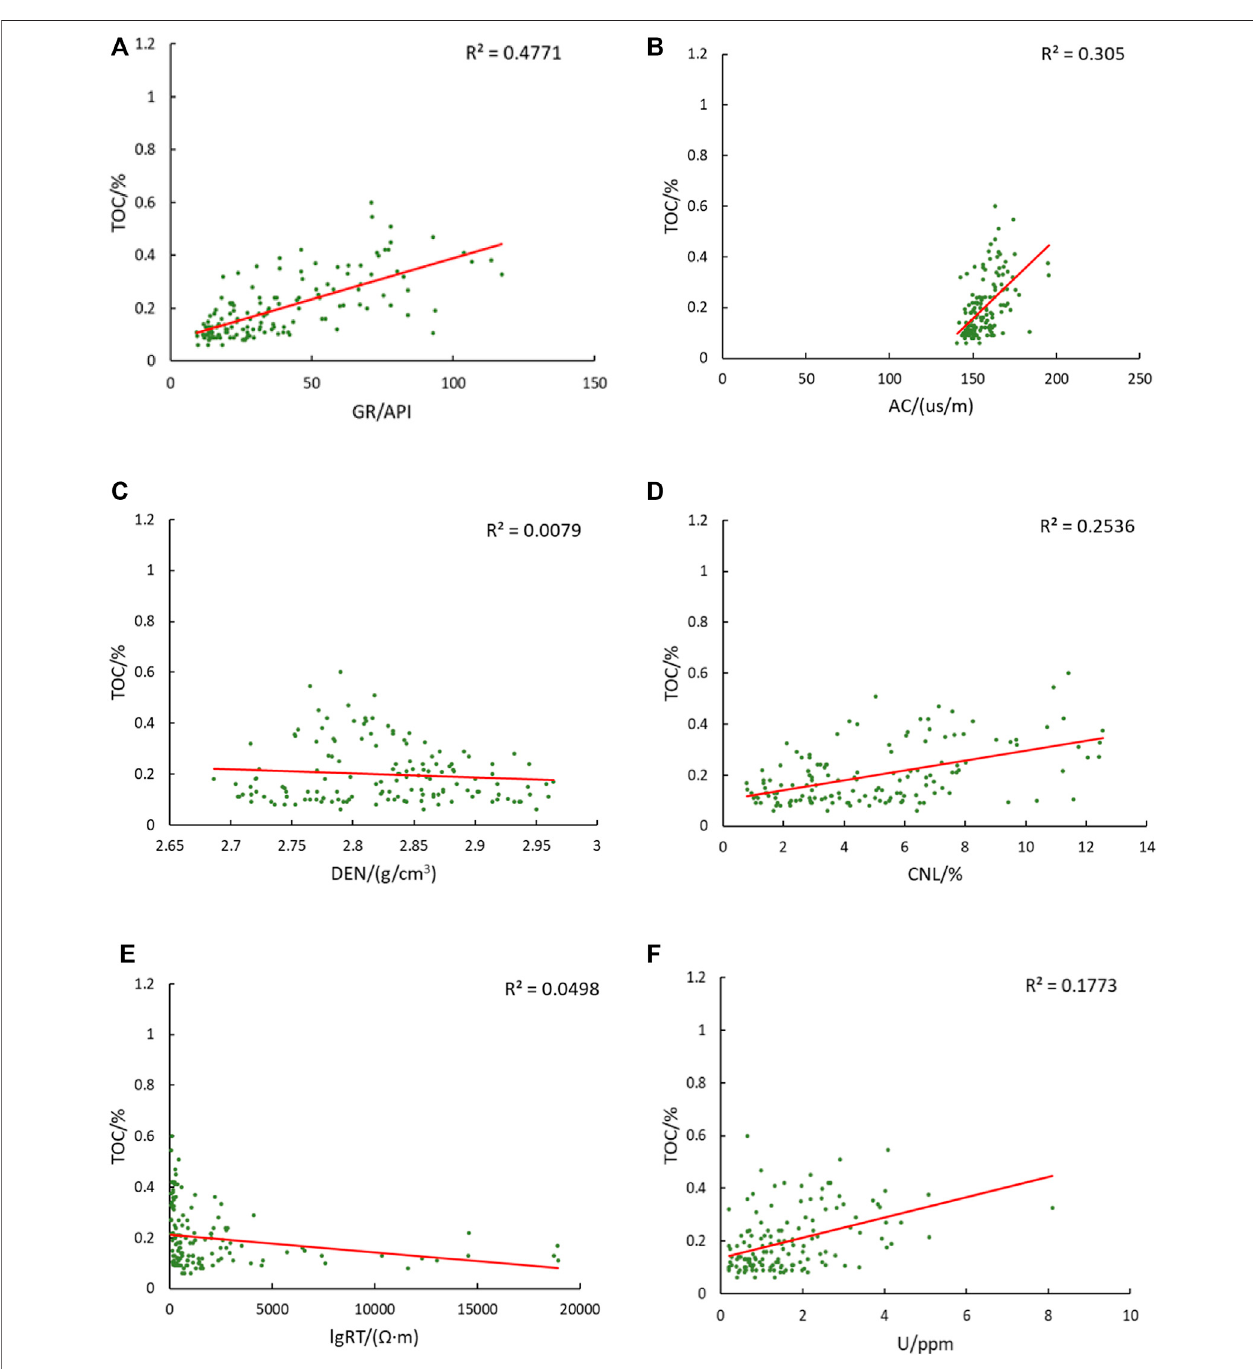
FIGURE 8 | Correlation between TOC content and (A) natural gamma ray, (B) acoustic time difference, (C) organic matter density, (D) neutron porosity, (E) formation resistivity, and (F) uranium, 145 samples in each fi gures.